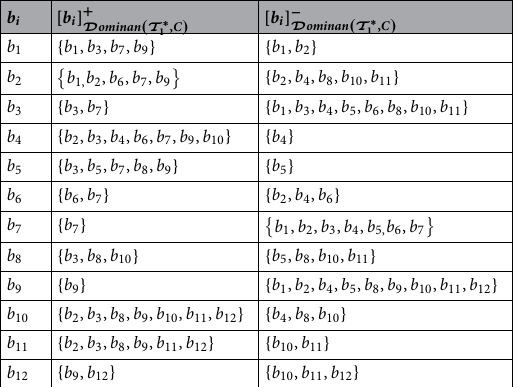
Table 2. Dominating classes [ b i ] + D ominan ( T ∗